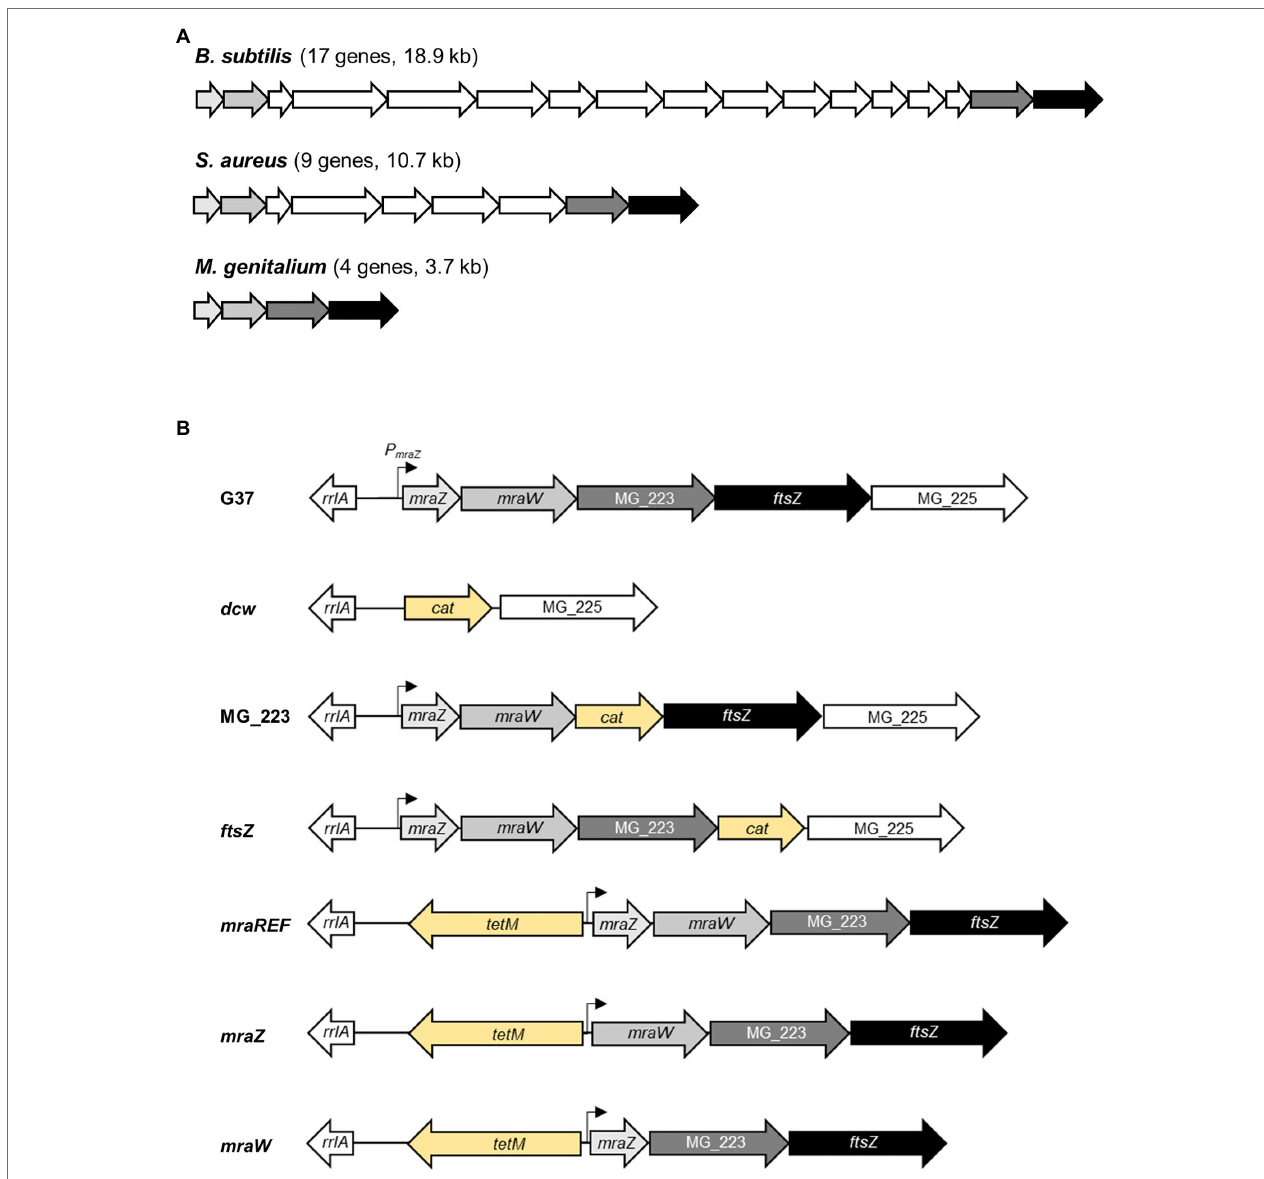
FIGURE 1 | Overview of the dcw gene cluster organization in selected bacteria. Scheme depicting the dcw gene cluster of three representative species of the Firmicutes phylum (A) . Bacillus subtilis (17 genes, 18.9 kb), Staphylococcus aureus (nine genes, 10.7 kb), and Mycoplasma genitalium (four genes, 3.7 kb). (B) Scheme of the cell division gene cluster in the different M. genitalium mutants created in this study. The promoter region of the mraZ gene (P mraZ ) was characterized in a previous report (Benders et al., 2005). The tetM or cat markers (in yellow) were introduced to select for the intended